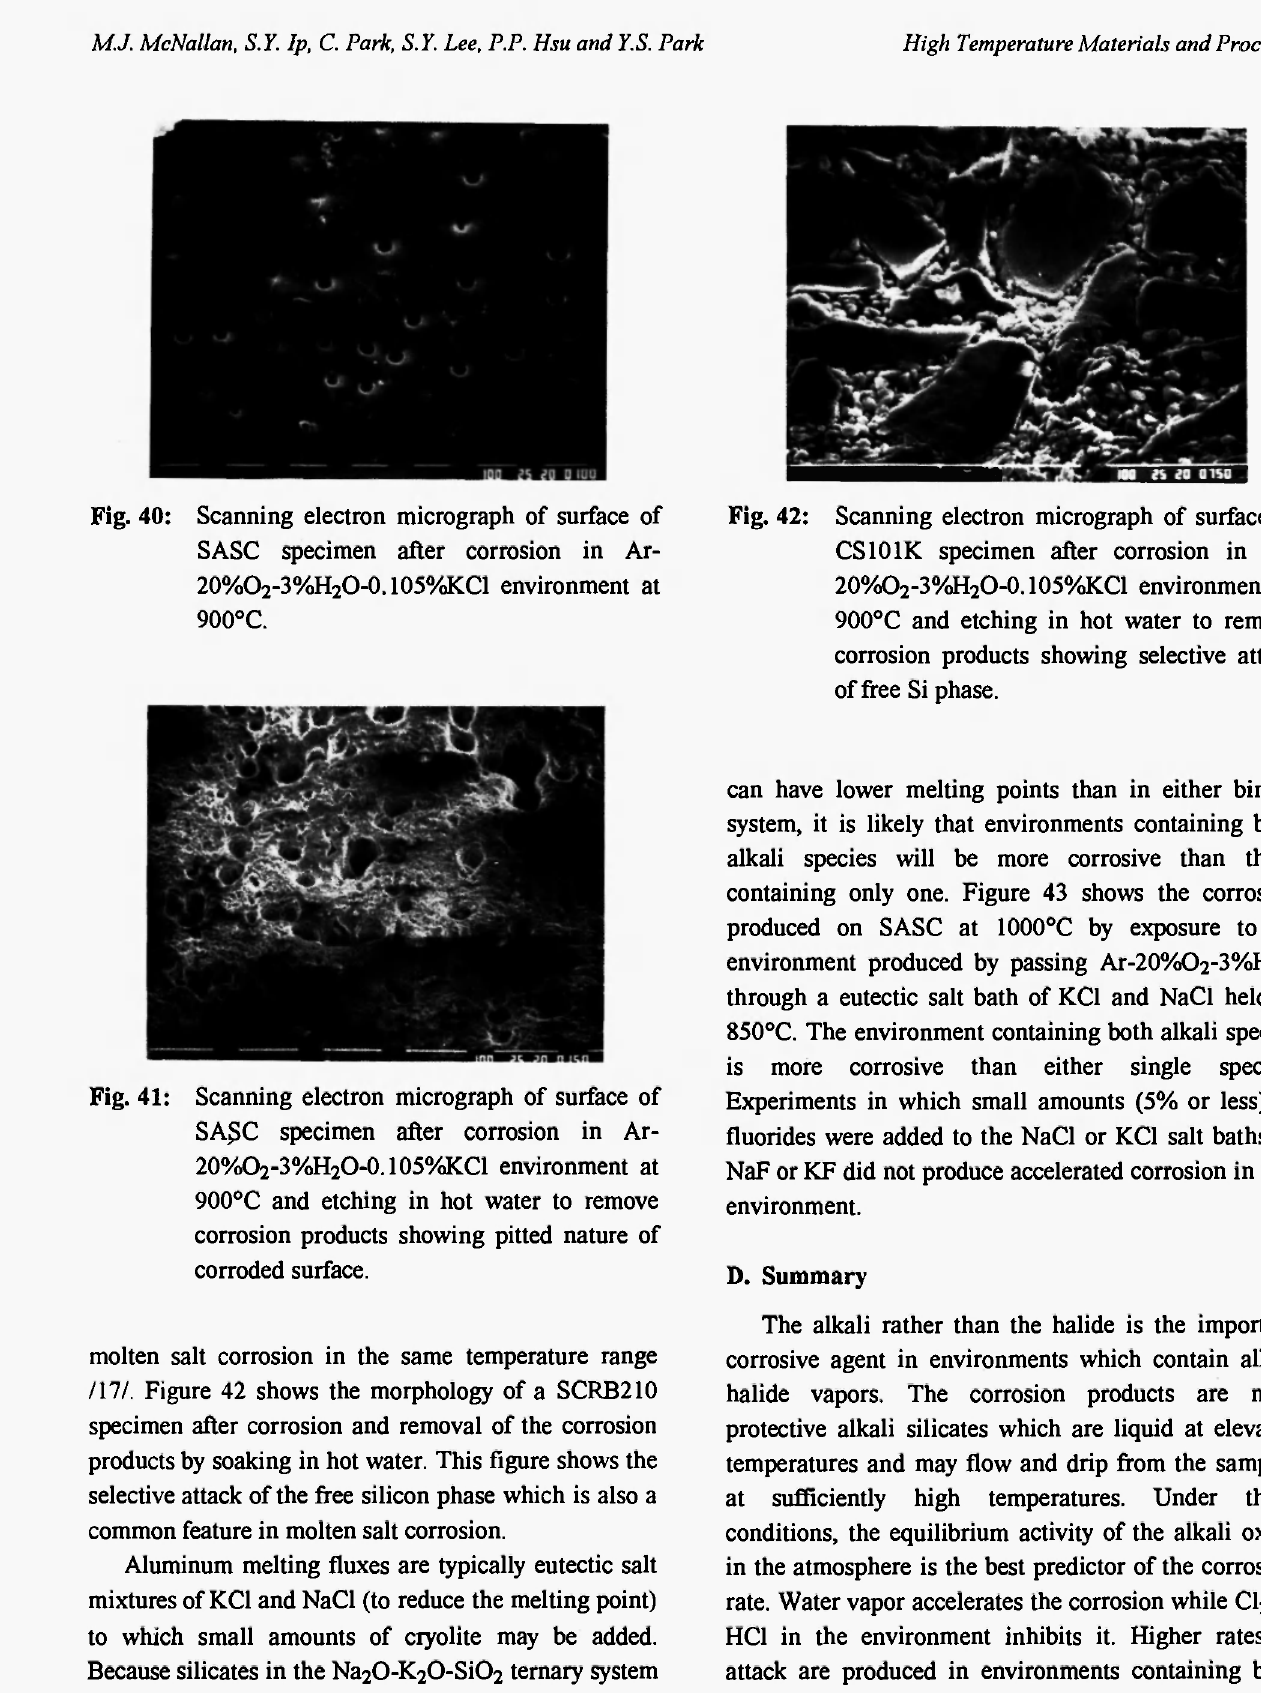
Fig. 41: Scanning electron micrograph of surface of SA£C specimen after corrosion in Ar- 20%0 -3%H 0-0.105%KC1 environment at 2 2 900°C and etching in hot water to remove corrosion products showing pitted nature of corroded surface.